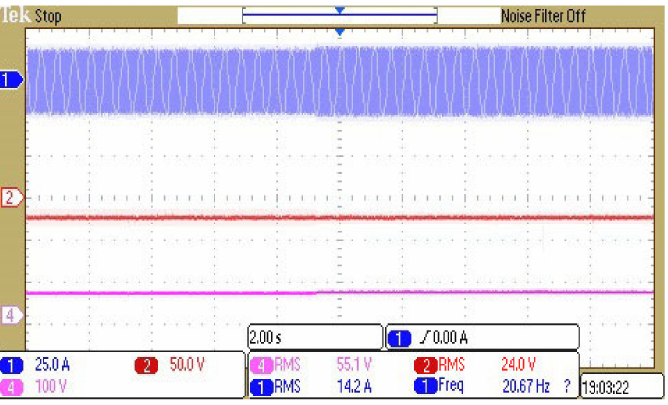
Figure 21. Waveform diagram of output voltage of load #1 and the track current I p .